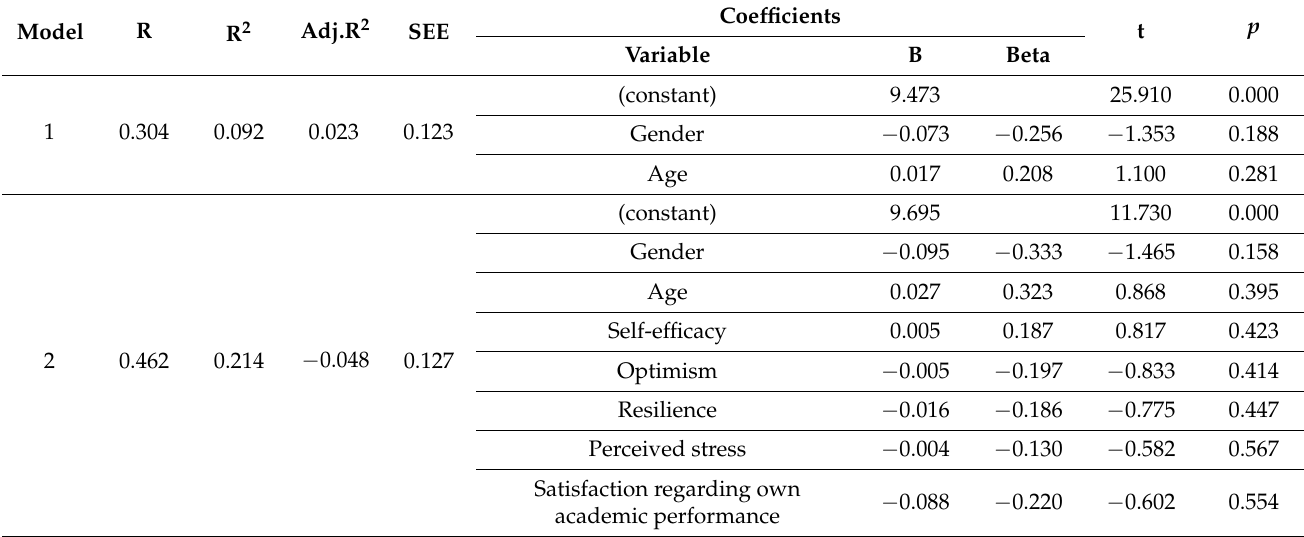
Table 3. Determinants of academic performance for students in the upper GPA quartile. (GPA > 9.64) ( N = 29) (linear